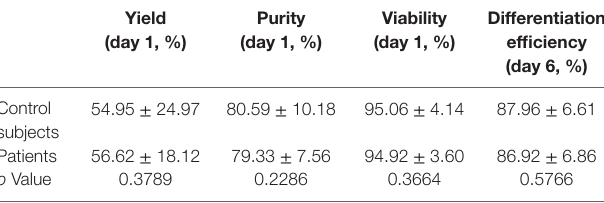
Table 3 | Data from monocyte’s isolation and dendritic cell differentiation. Yield (day 1,